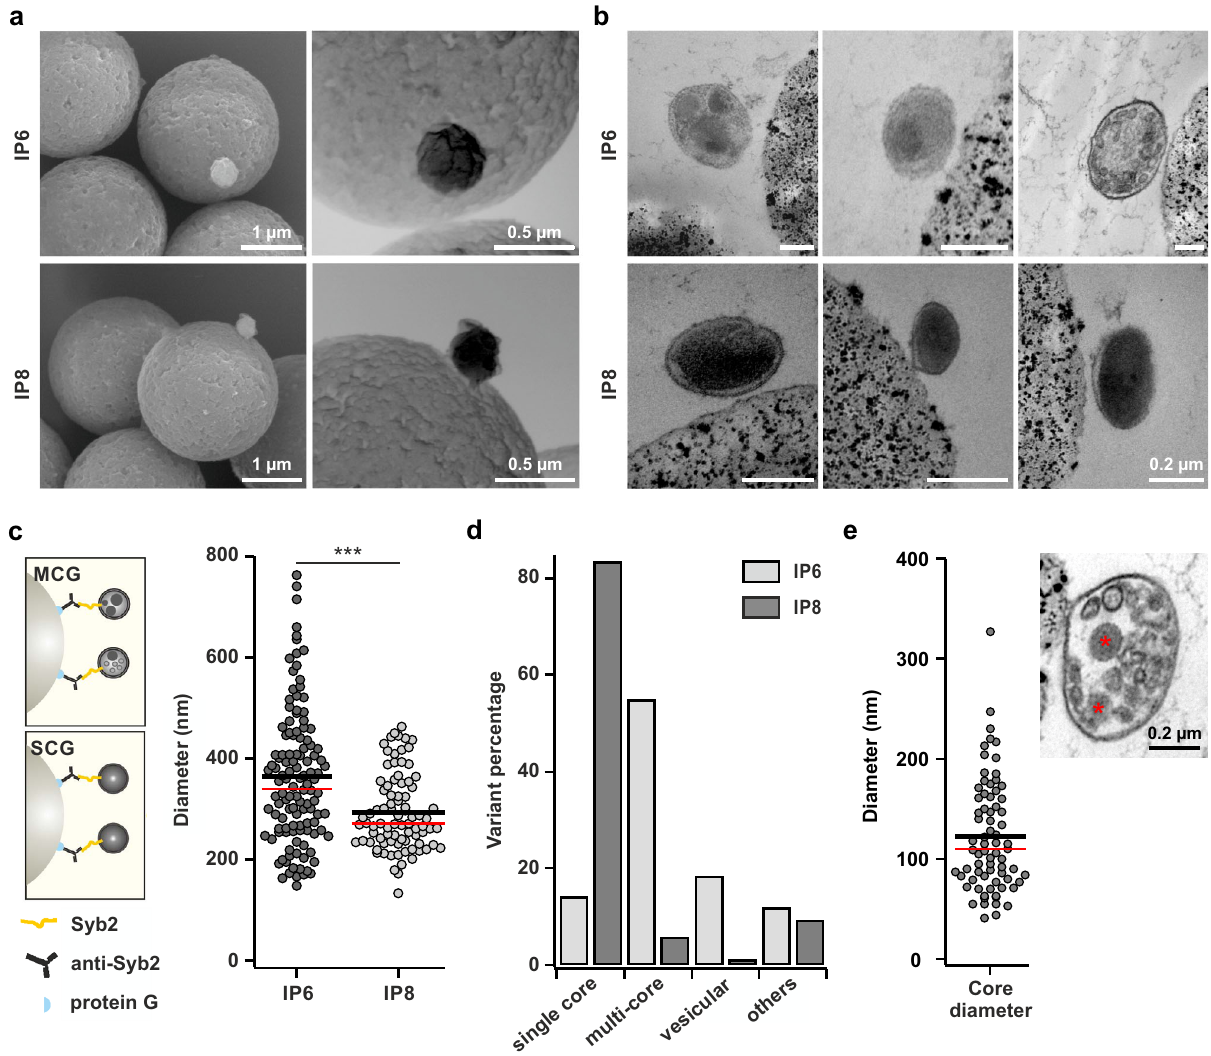
Fig. 3 SEM/TEM analysis discerns two types of morphological distinct cytotoxic granules after immunoprecipitation. a Representative scanning electron microscope (SEM) images of organelles derived from IP6 and IP8 following immunoprecipitation with anti-synaptobrevin2 antibody (N IP = 2, n granules = 21 and 19 for IP6 and IP8, respectively). Left: SEM image in secondary electron mode. Right: SEM image in back scattered mode. b Three representative TEM images of IP6 and IP8 display a heterogeneous population of multi core granules (MCG; upper row) and a homogenous population of single core granules (SCG; lower row), respectively. c Scheme of MCG and SCG (left) and diameter analysis (right) of MCGs in IP 6 (N IP = 3, n granules = 118) and SCGs in IP 8 (N IP = 3, n granules = 85, p < 0.001) as shown in ( b ). d Quanti fi cation of morphological variants of the organelles from IP6 and IP8 as shown in ( b ). Percentage of organelles classi fi ed into four groups based on their ultrastructural features: single core (uniformly electron dense), multicore (small dense cores with or without small vesicles), vesicular (many small vesicles) and others. The observed distribution of organelles in the four categories between IP6 and IP8 are signi fi cantly different ( χ 2 = 102.73 and df = 3, p < 0.001). e Quanti fi cation of dense core diameter observed in MCGs (N IP = 3; n granules = 74) as shown in ( b ). Inset: representative image of MCG containing small dense cores marked with asterisks. In all scatter dot plots black line represents mean and red line median. Source data are provided as a Source data fi